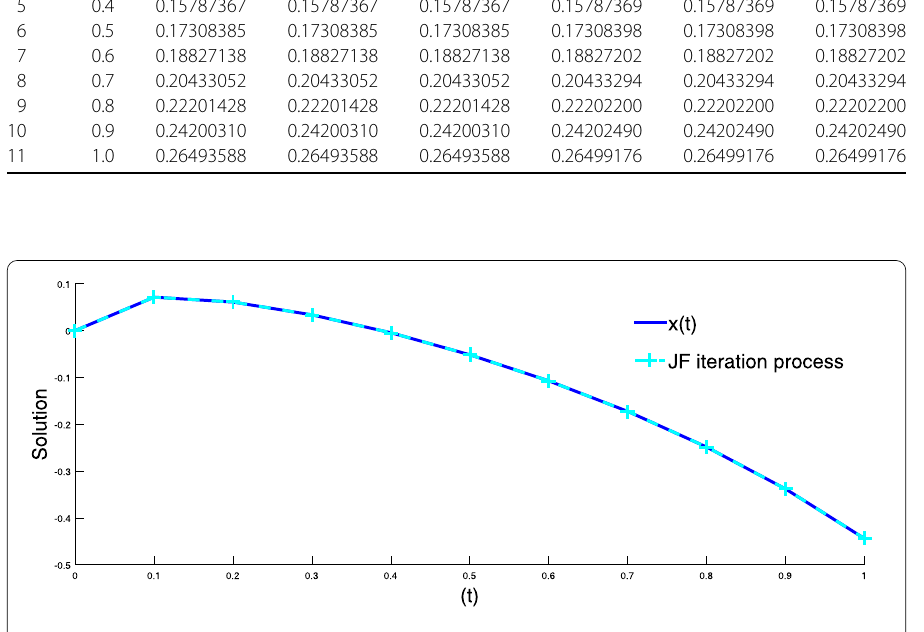
Figure 3 Graphical representation of exact solution and approximated solution of problem (6.3) by using the JF iteration process at k = 3